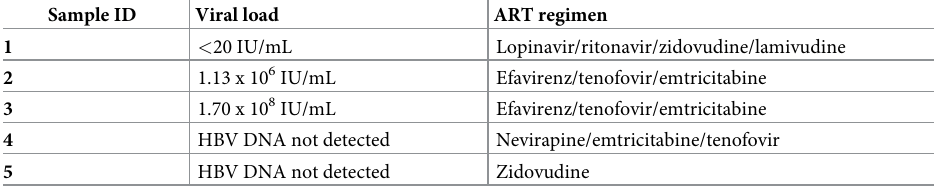
Table 3. Viral load and ART regimen for HBsAg positive